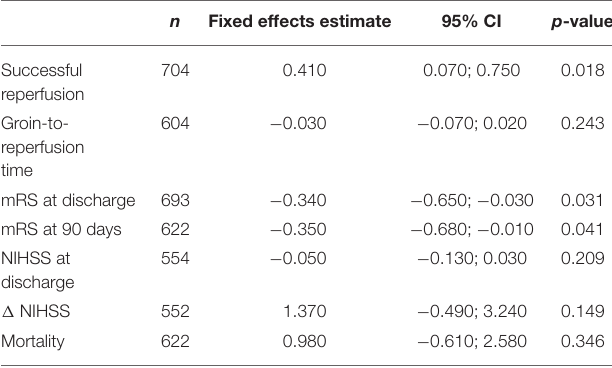
TABLE 3 | Adjusted analysis of outcome parameters and bridging IVT using linear mixed effect